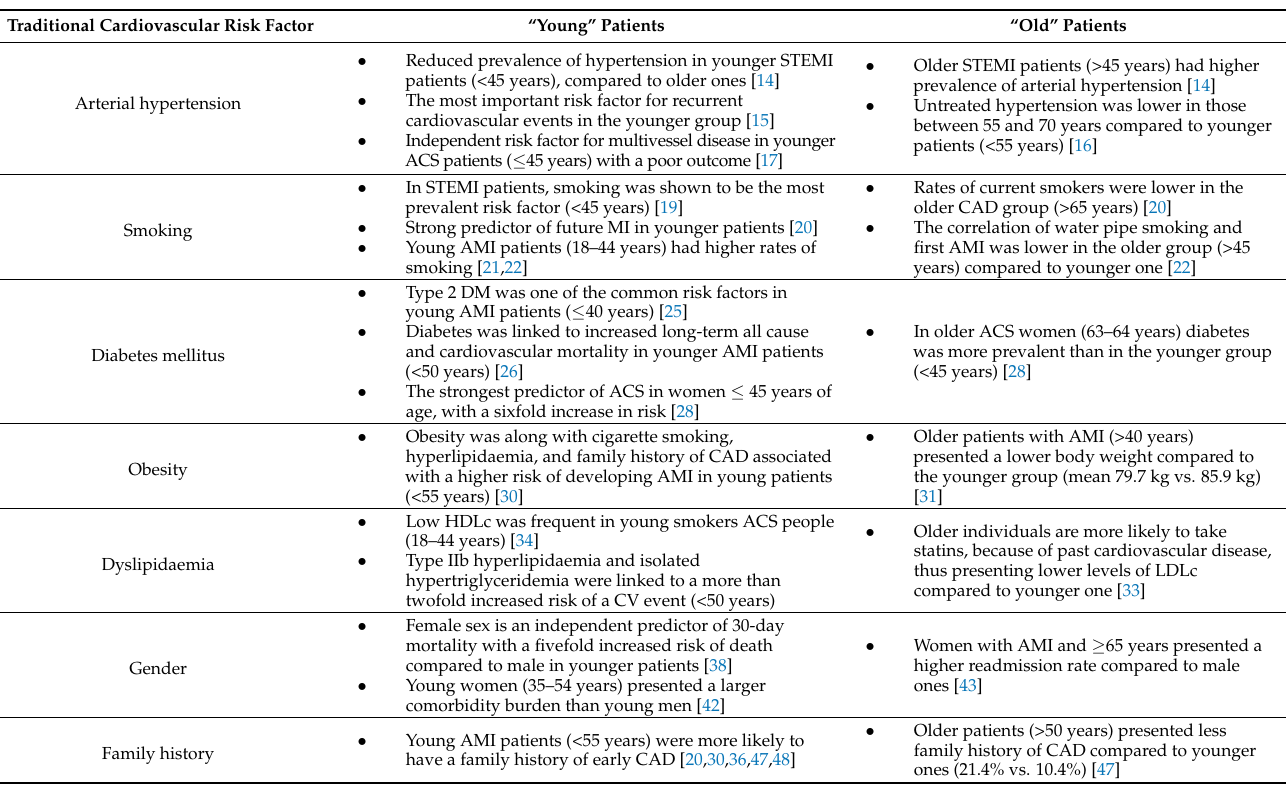
Table 1. Traditional cardiovascular risk factors in “young” vs. “old” patients with myocardial infarction. Traditional Cardiovascular Risk Factor “Young” Patients “Old”